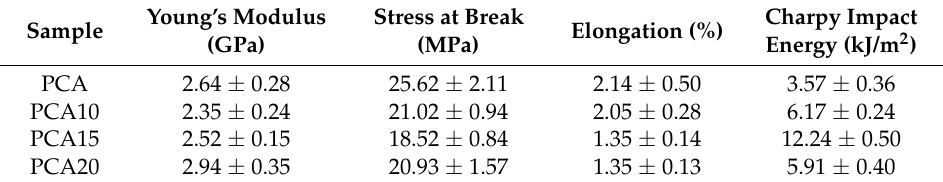
The values are the mean ± SD of at least five determinations.